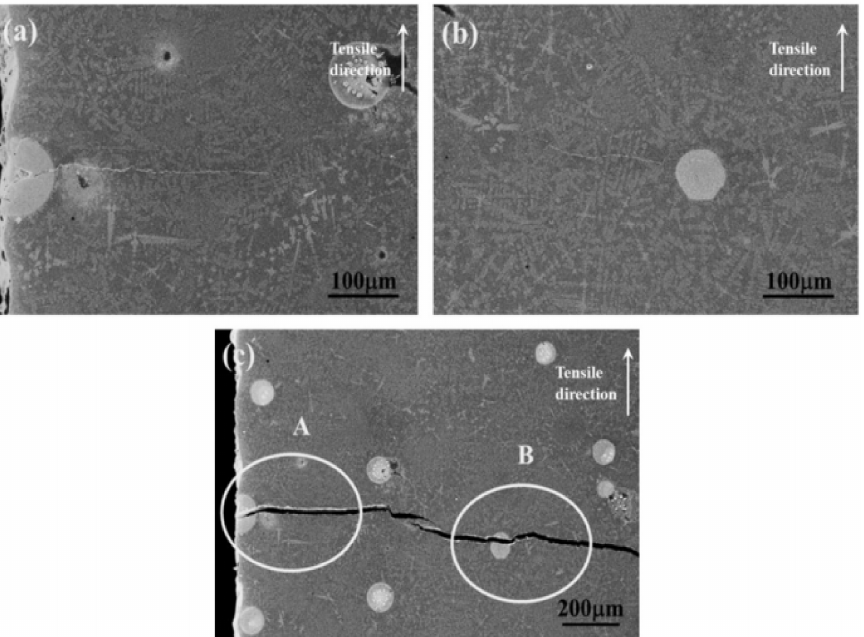
Figure 3. The initiation and propagation of crack at the composite coating surface with 6.20 vol% WC at various strain values: ( a , b ) 0.21% and ( c ) 0.76% [10].